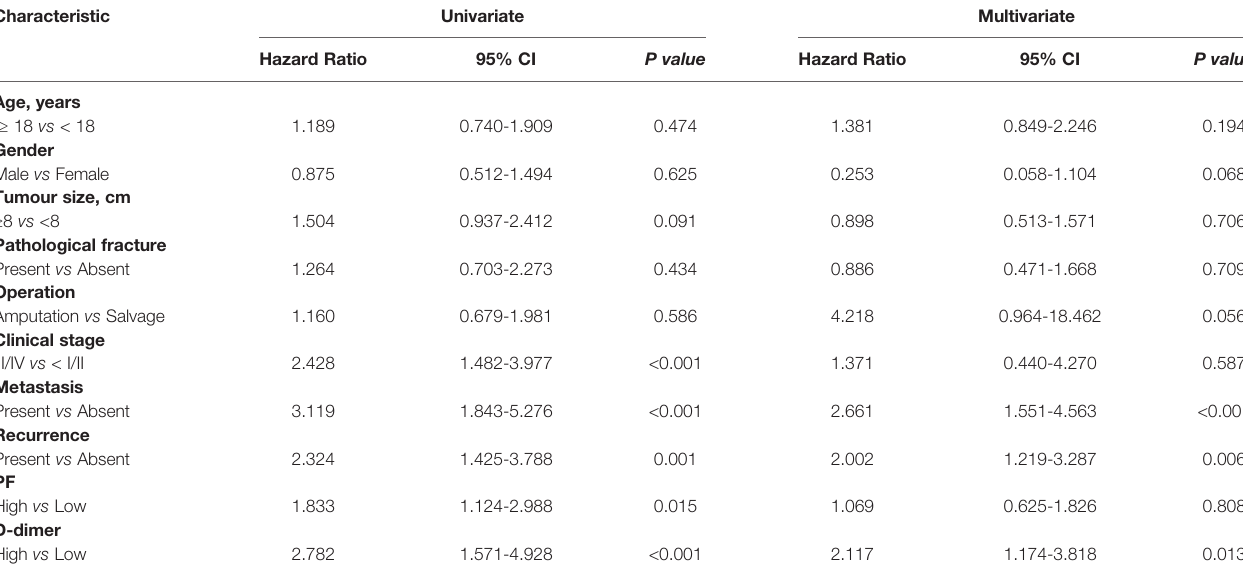
TABLE 2 | Univariate and multivariate analyses of PF and D-dimer expression in relation to OS in patients with osteosarcoma.